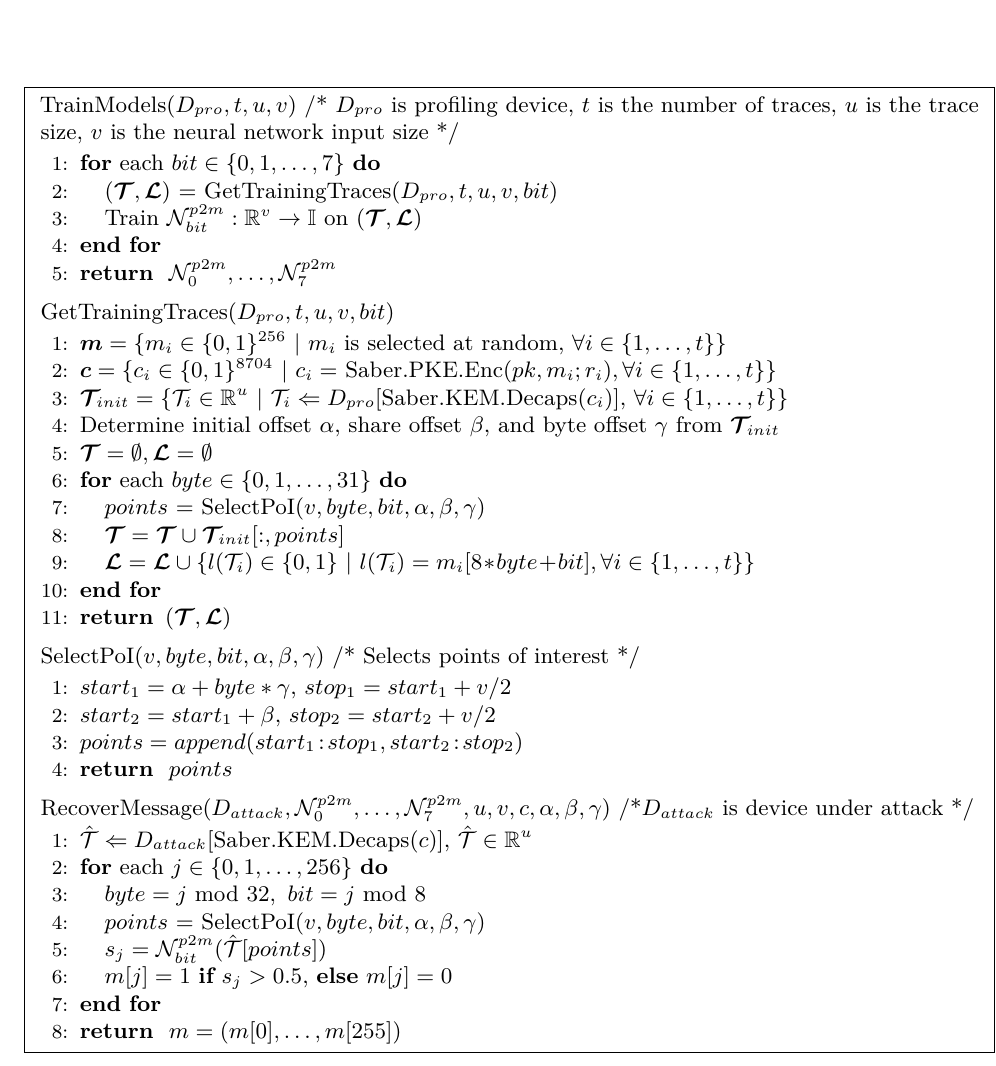
Figure 7: Pseudocode of the message recovery attack using POL2MSG()